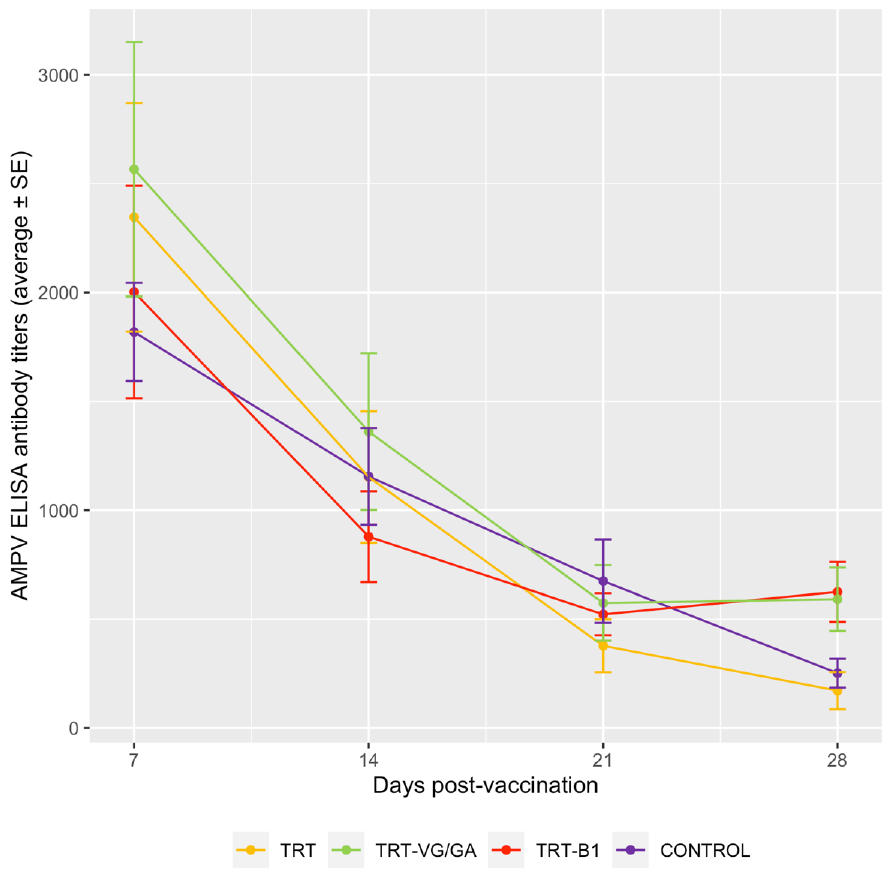
Figure 2. Mean anti-aMPV antibody titers measured by ELISA in aMPV-vaccinated turkeys and the control group.